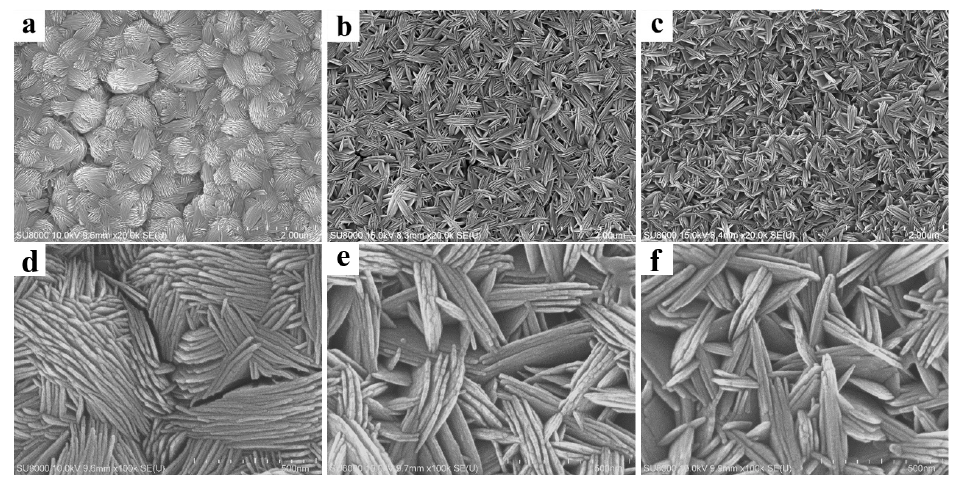
Figure 1. SEM surface morphologies of anatase coatings: ( a , d ) MgZn–0.1 F; ( b , e ) MgZn–0.2 F; ( c , f ) MgZn–0.3 F.